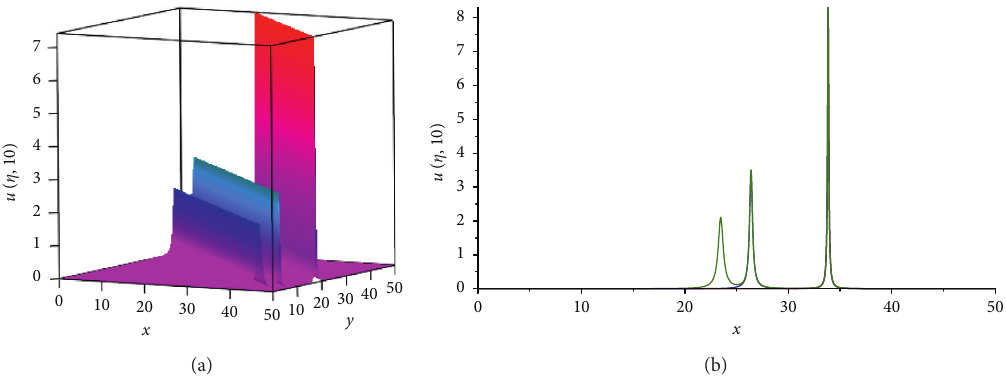
Figure 3: The fission of an algebraic gravity solitary wave at t � 10. (a) Space diagram. (b) Planar